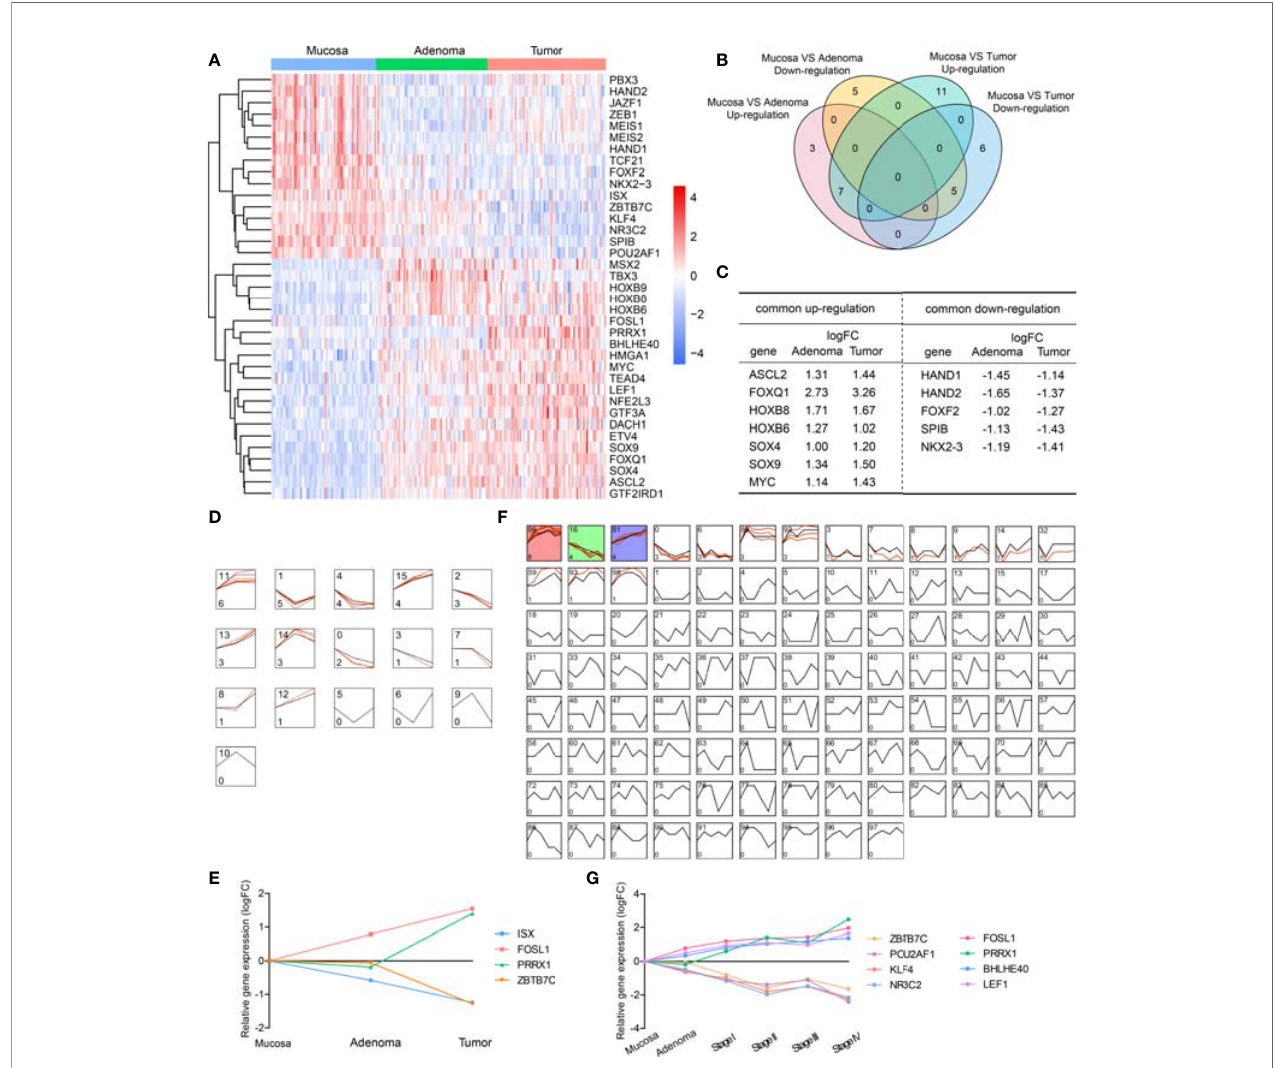
FIGURE 1 | Differentially expressed transcription factors (DE-TFs) at different evolutionary stages of CRC and their expression patterns. (A) All up-regulated and down-regulated DE-TFs were hierarchically placed and presented in a heatmap. (B) Venn diagram depicted the common DE-TFs shared by adenoma vs mucosa, and tumor vs mucosa. (C) The commonly shared DE-TFs in (B) and their fold changes were listed. (D – G) Gene expression models in the mucosa-adenoma-tumor sequence (D) or mucosa-adenoma-tumor sequence with tumor staging (F) were identi fi ed by STEM software and representative gene expression patterns was shown in (E, G) . Colored models meant a statistically signi fi cant number of genes were enriched. The number on the top left corner indicated the serial number of models and the bottom left corner indicated the number of genes